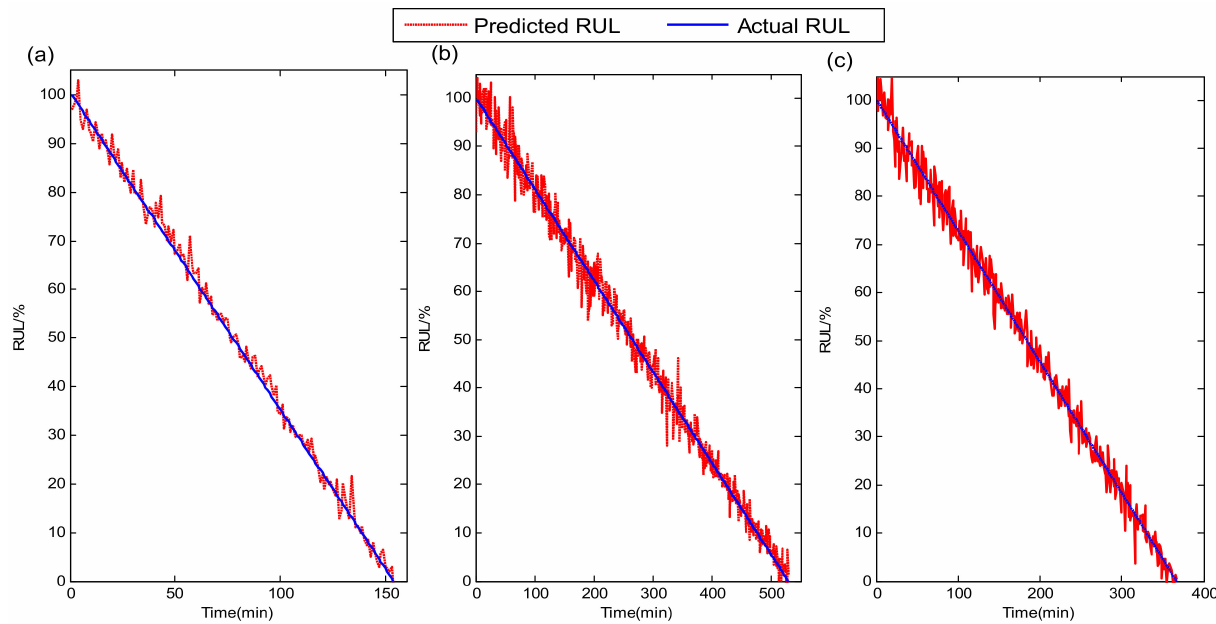
Figure 14. RUL prediction results of the XJTU-SY dataset. ( a ) bearing1_3; ( b ) bearing2_3; ( c )